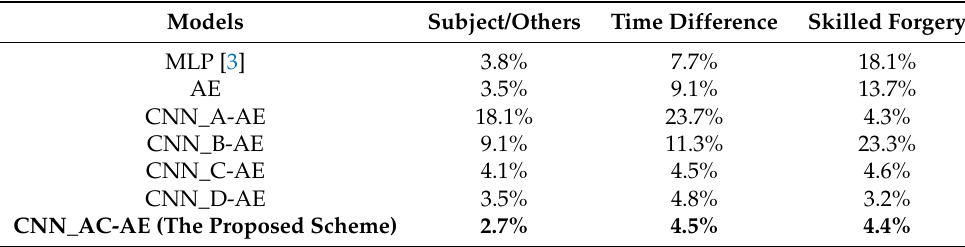
Table 3. CNN-AE classification comparison with